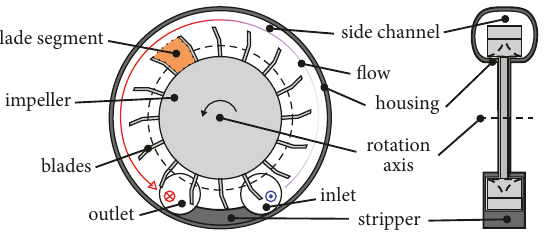
Figure 1: A double-flow side channel blower with radial, open